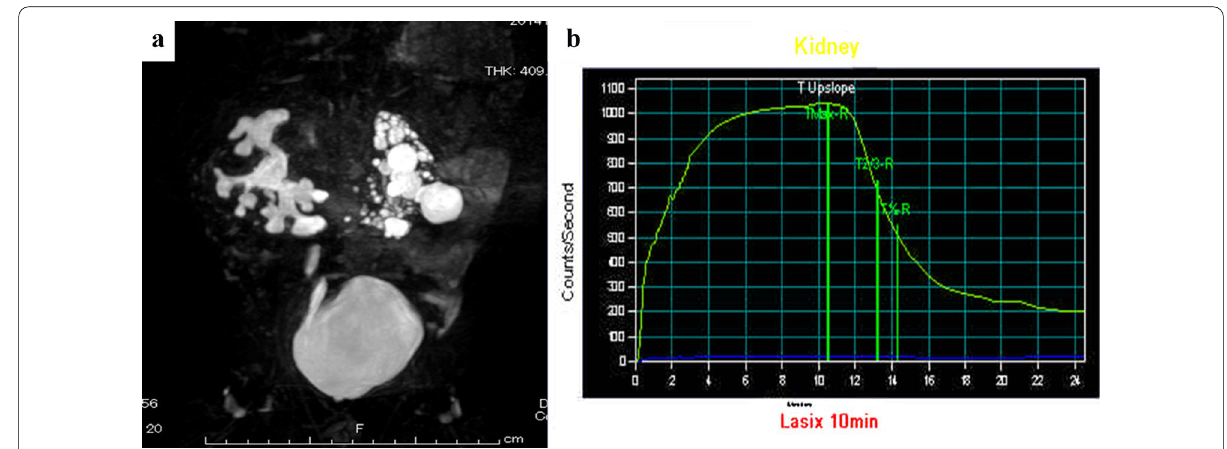
Fig. 5 Postoperative MRU and renal scintigraphy findings. a MRU, b